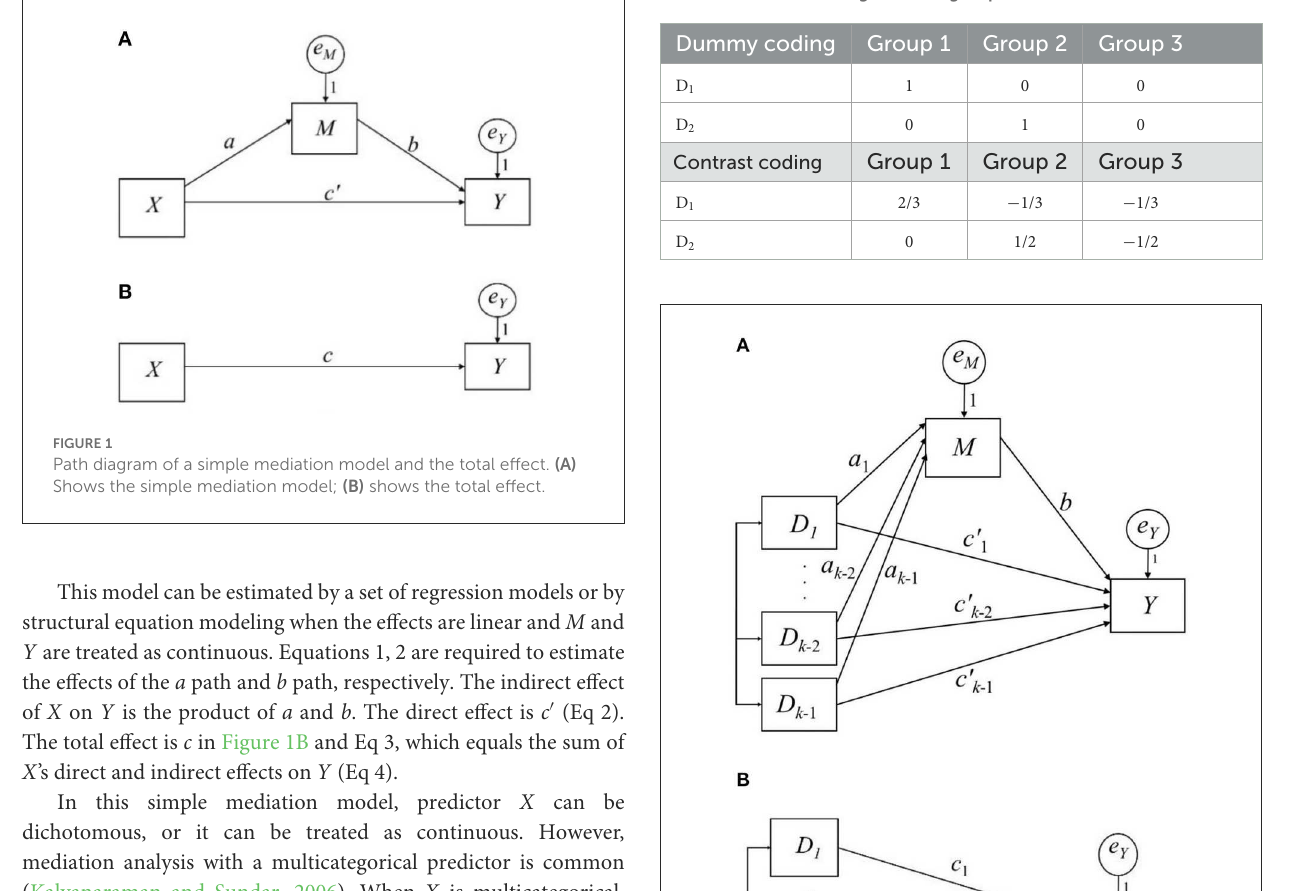
TABLE 1 Contrast coding for three groups.